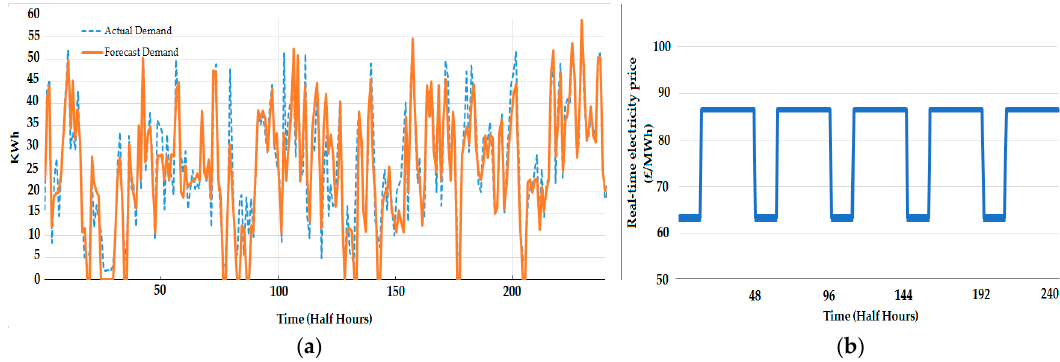
Figure 8. Profiles of ( a ) the actual and forecast electrified RTG crane demand; ( b ) the real-time electricity price.